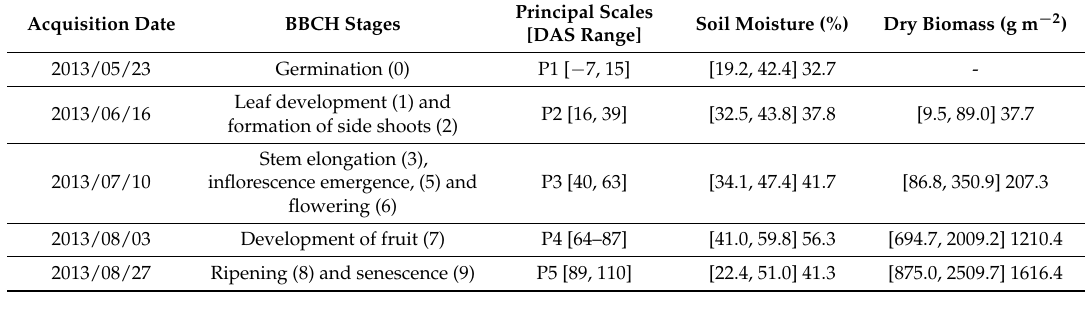
Table 3. Principal stages of rape and the related Biologische Bundesanstalt Bundessortenamt und CHemische Industrie (BBCH) scales.